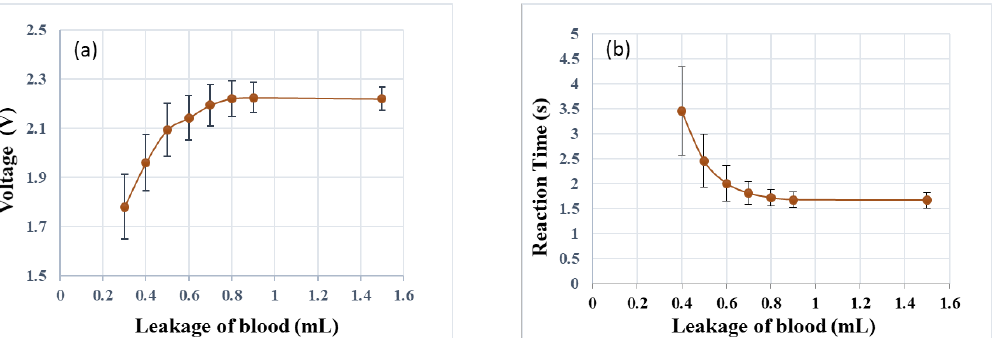
Figure 8. The relationship between the volume of blood leakage and ( a ) the sensor voltage and ( b ) the reaction time of the leakage-detection patch, respectively.